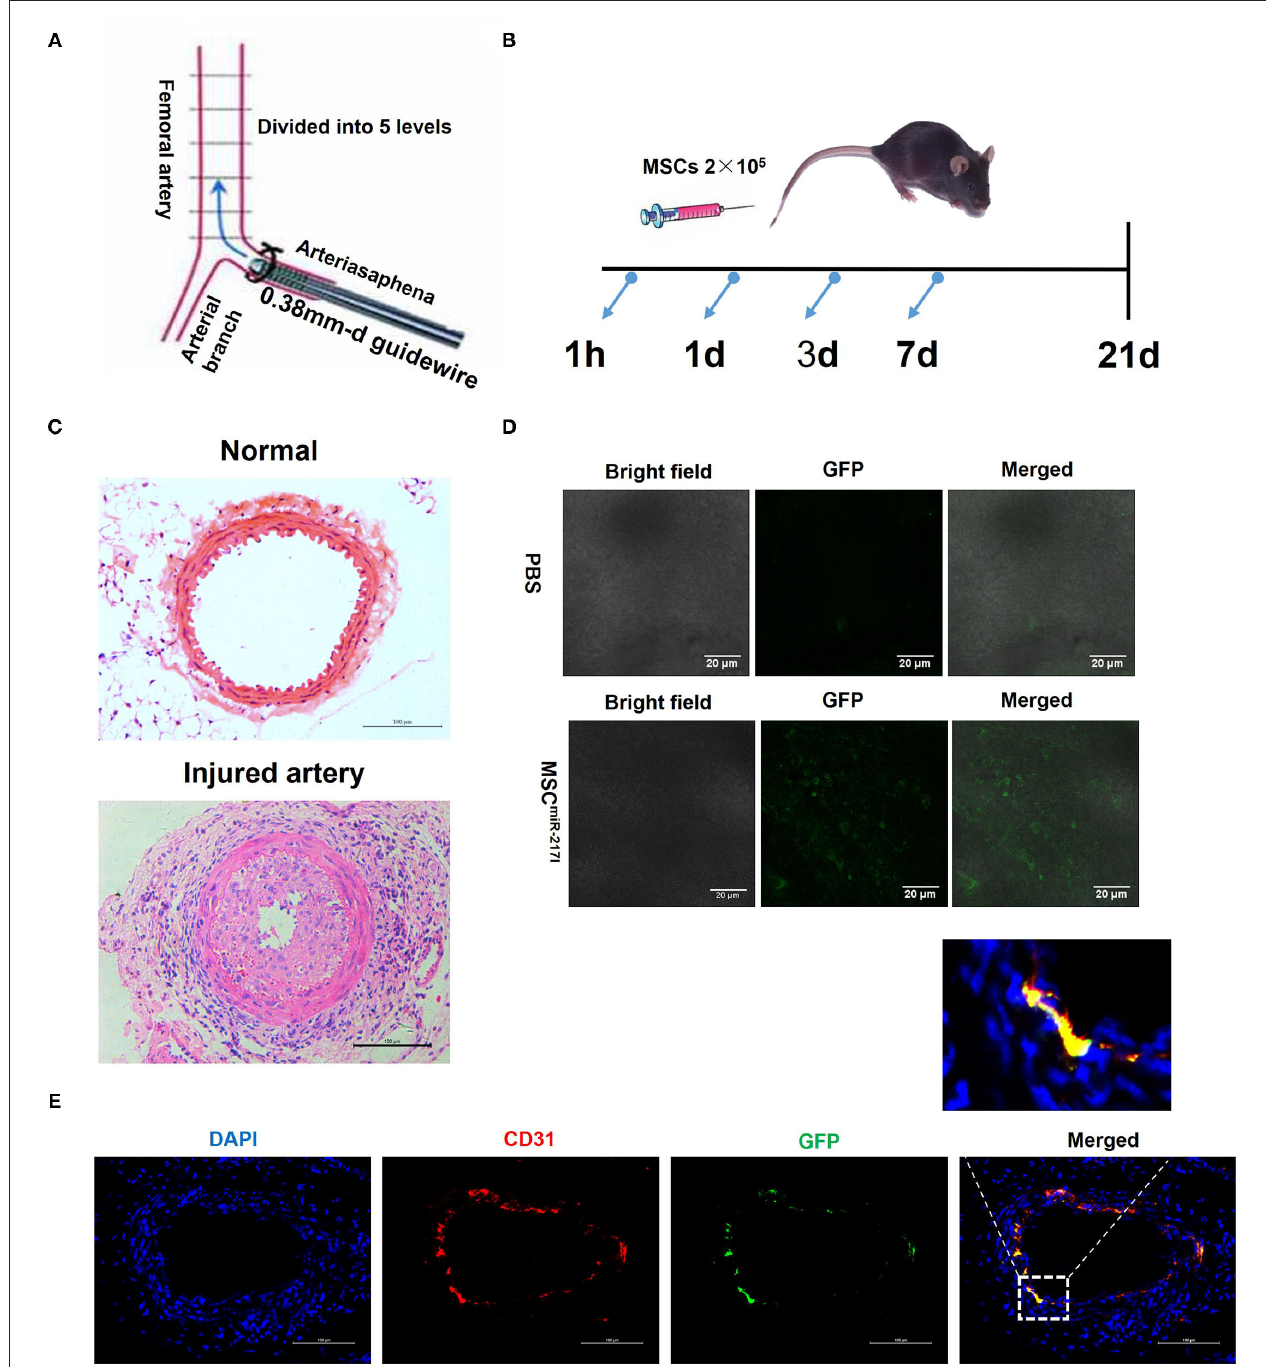
FIGURE 2 | A femoral artery injury model in mice. (A) A schematic representation of the surgical procedure. (B) A schematic representation about the cell treatment procedure after the femoral artery injury. (C) A representative image of uninjured femoral artery and neointima formation 21 days after endothelial cell damage. Scale bars = 100 µ m. (D) MSCs home to the vascular injury site at 24h after injection; 2 × 10 5 GFP-labeled MSCs were intravenously infused directly in the mouse tail vein following the femoral artery injury, and 24h later the presence of GFP-labeled cells was analyzed by fluorescence microscopy. Representative confocal microscopy images show that the injected MSCs localized exclusively to the site of injury. Scale bars = 20 µ m. (E) Immunofluorescent analysis revealed differentiation of engrafted GFP-labeled MSC miR − 217I into endothelial cells at day 21 after cells injection.